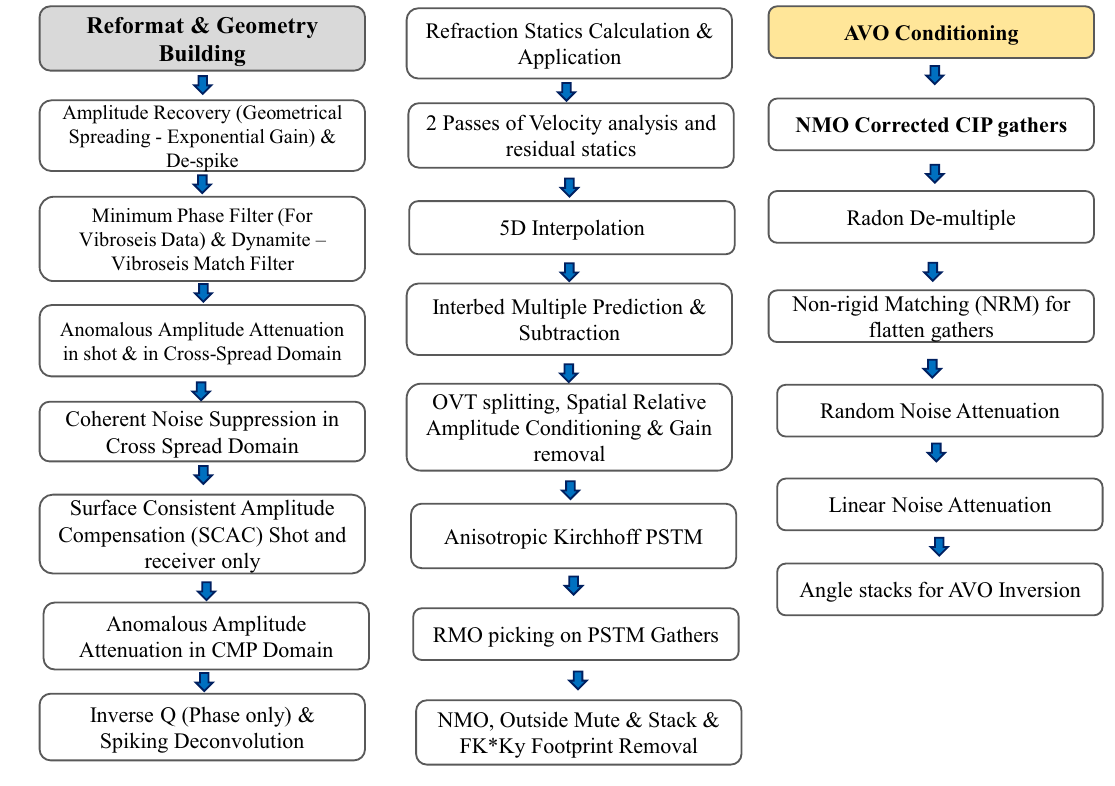
Fig. 4 Customized AVO compliant seismic data conditioning workflow